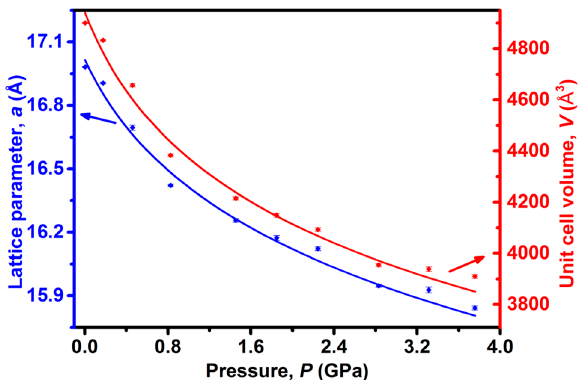
Figure 7. Pressure-dependent unit cell volume ( V , blue) and lattice parameter ( a , red). The experimental data are shown with error bars, and the red and blue lines indicate the second-order Birch-Murnaghan fits derived from a PASCAL program [25].